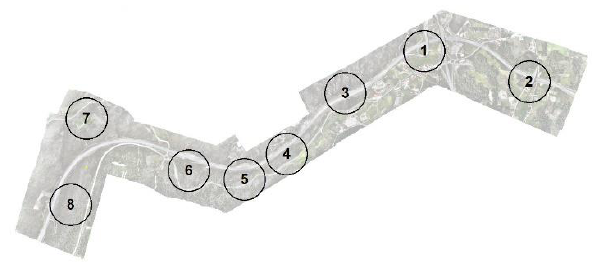
Figure 7. Location of the 8 patches for matching the UAV point cloud with the DSM.